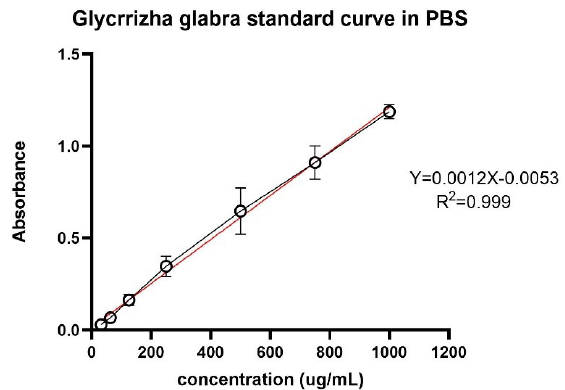
Figure 3. Standard Curve of the Licorice Extract in the PBS Buffer. Note. PBS: Phosphate-buffered